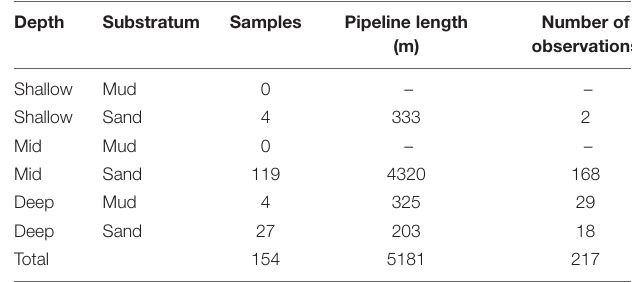
TABLE 1 | Summary of the number ROV footage samples analyzed to identify features of conservation interest and the total length of pipeline reviewed, according to depth and substratum